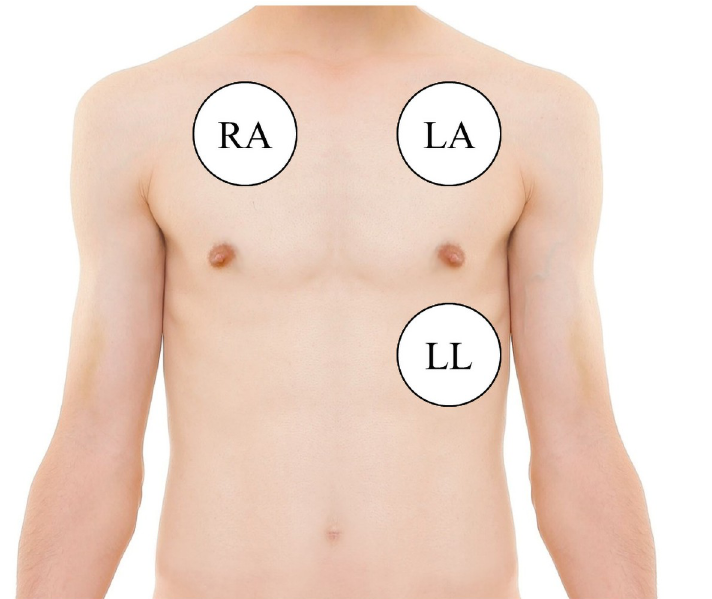
Fig 3. Position of adhesive electrodes for ECG